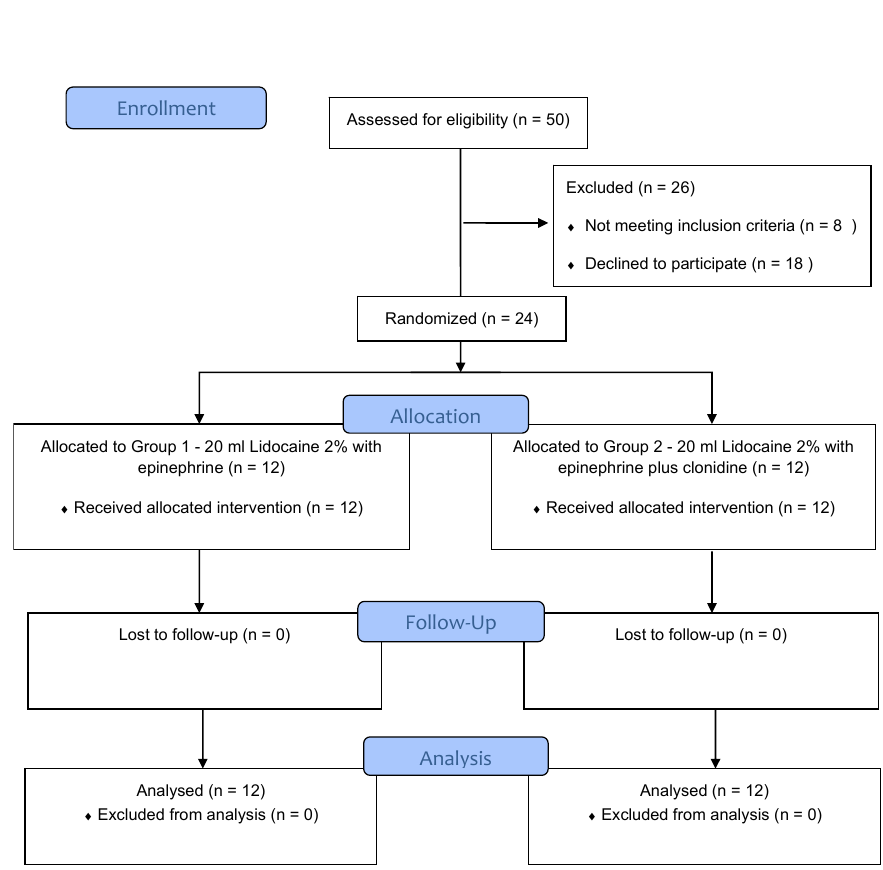
Figure 1. CONSORT patient flow diagram. n =